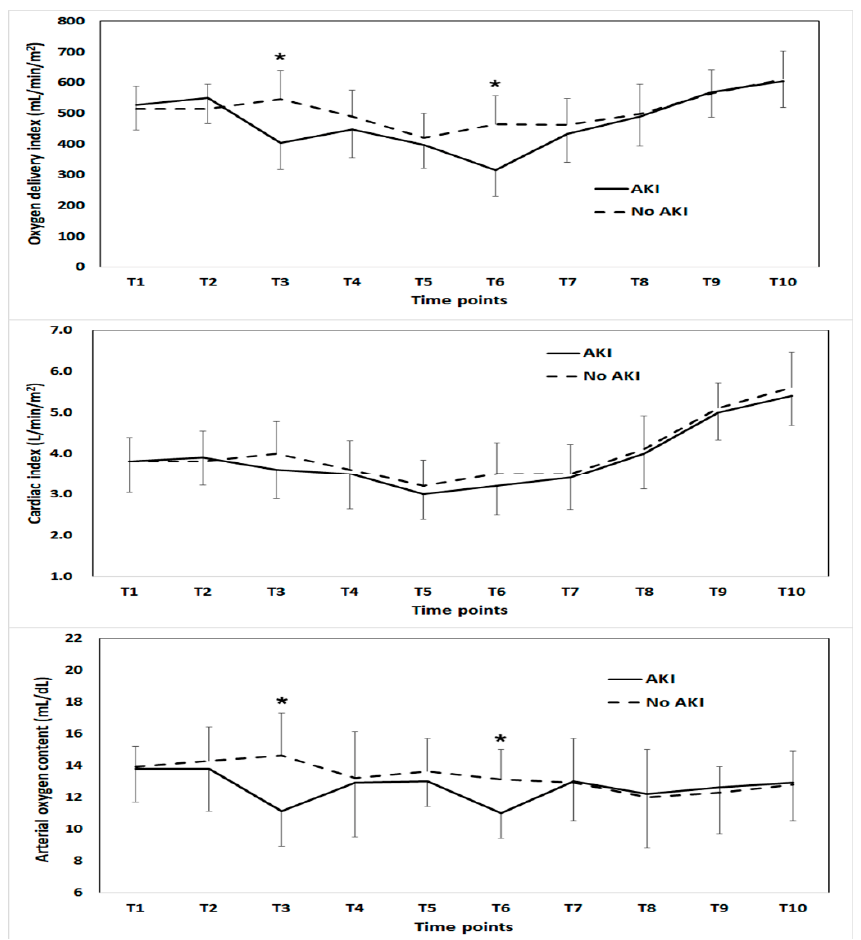
Figure 1. Comparison of oxygen delivery index (upper), cardiac index (middle) and arterial oxygen content (lower) during liver transplantation between the patients with and without acute kidney injury. The time points compared were as follows: anesthesia induction (T1), 1 h after anesthesia induction (T2), 30 min (T3) and 1 h (T4) after the beginning of the anhepatic phase, 5 min before (T5) and after (T6) graft reperfusion, 20 min after reperfusion (T7), 40 min after reperfusion (T8), 5 min after the completion of biliary reconstruction(T9), and at the end of surgery (T10). * Significant difference between groups.